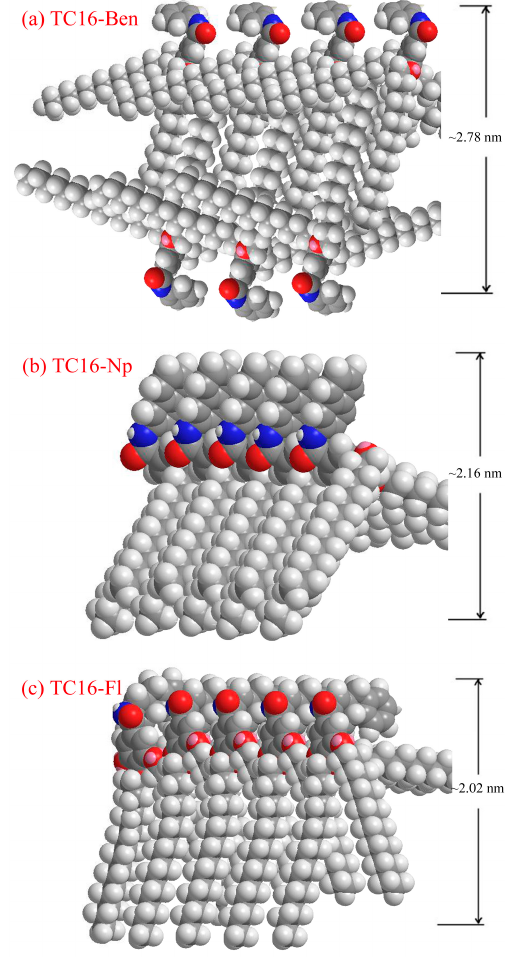
Figure 8. Schematic pictures of rational assembly modes for present amide compounds in gels: ( a ) TC16-Ben; ( b ) TC16-Np; ( c ) TC16-Fl.